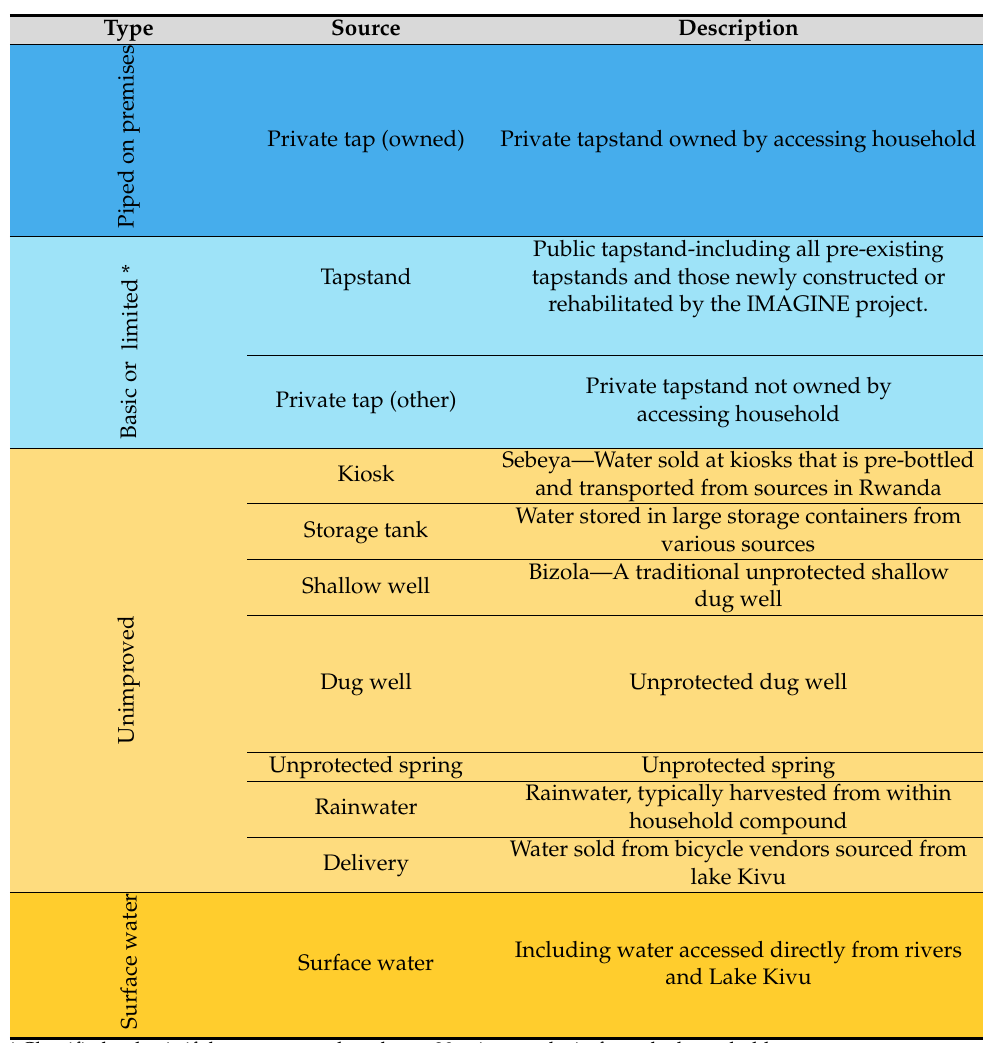
Table 1. Water source types identified as being in use in the study